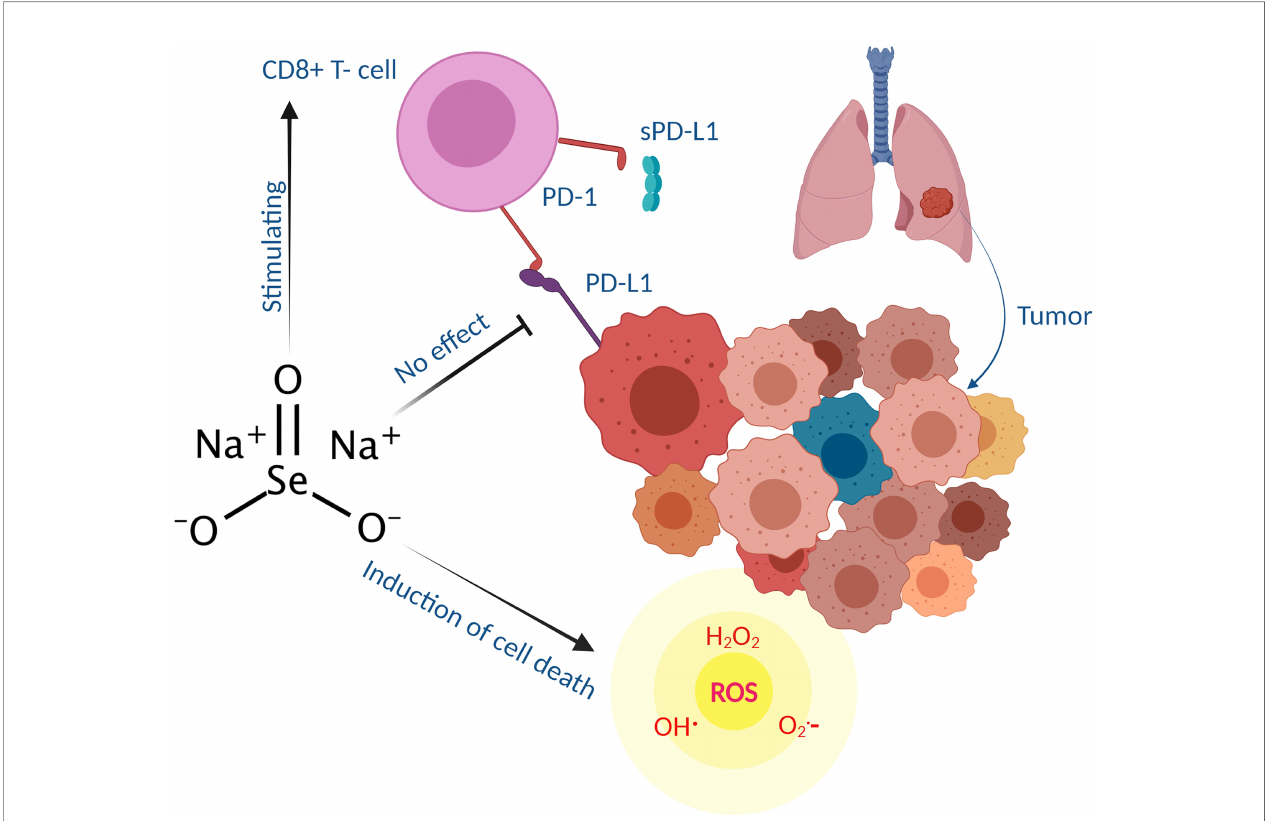
FIGURE 2 | Schematic illustration showing that sodium selenite stimulates cytotoxic CD8 T -cells induce cell death through reactive oxygen species (ROS) generation in cancer patients (mostly lung adenocarcinoma) while having no effects on PD-L1 expression. Biologically, sPD-L1 inhibits the proliferation of T cells (particularly CD8+ subgroup) by PD-L1/PD-1 cross talk thus associated with immunosuppression